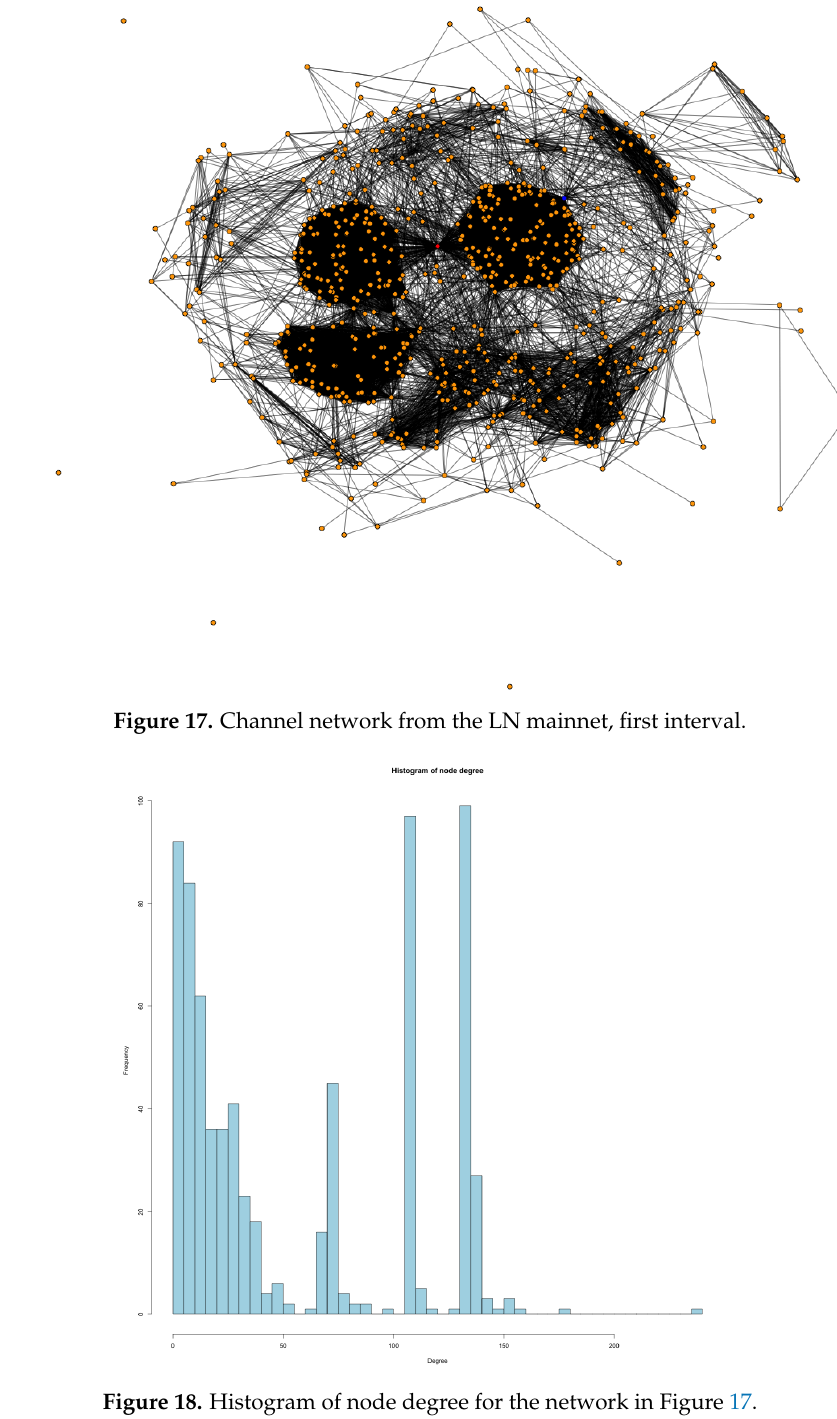
Figure 18. Histogram of node degree for the network in Figure